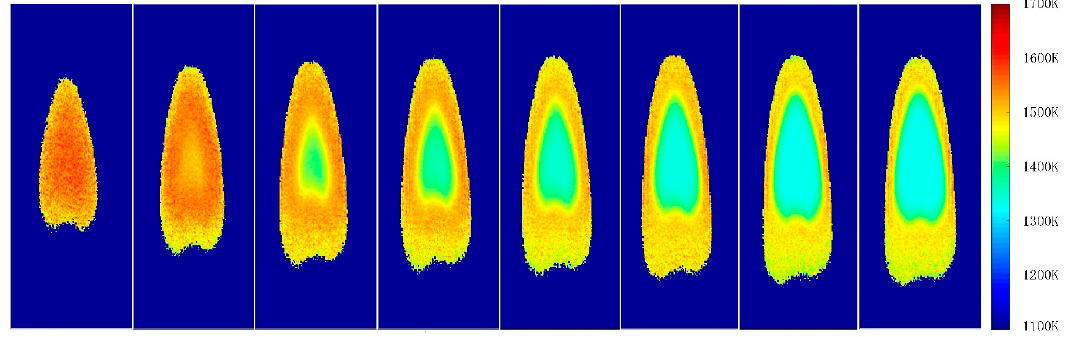
Figure 6. Original temperature distributions.